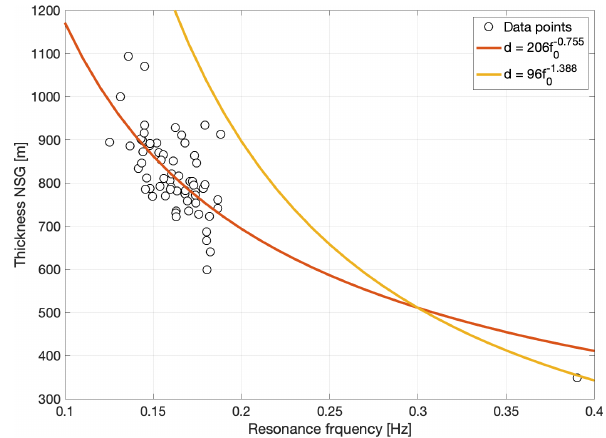
Figure 9. The thickness of NSG versus fundamental resonance fre- quency f 0 distribution for 63 sites in Groningen (black circles), to- gether with the least-squares fitted function (orange line) and the empirical model for the Aachen region (yellow line) as obtained by Ibs-von Seht and Wohlenberg